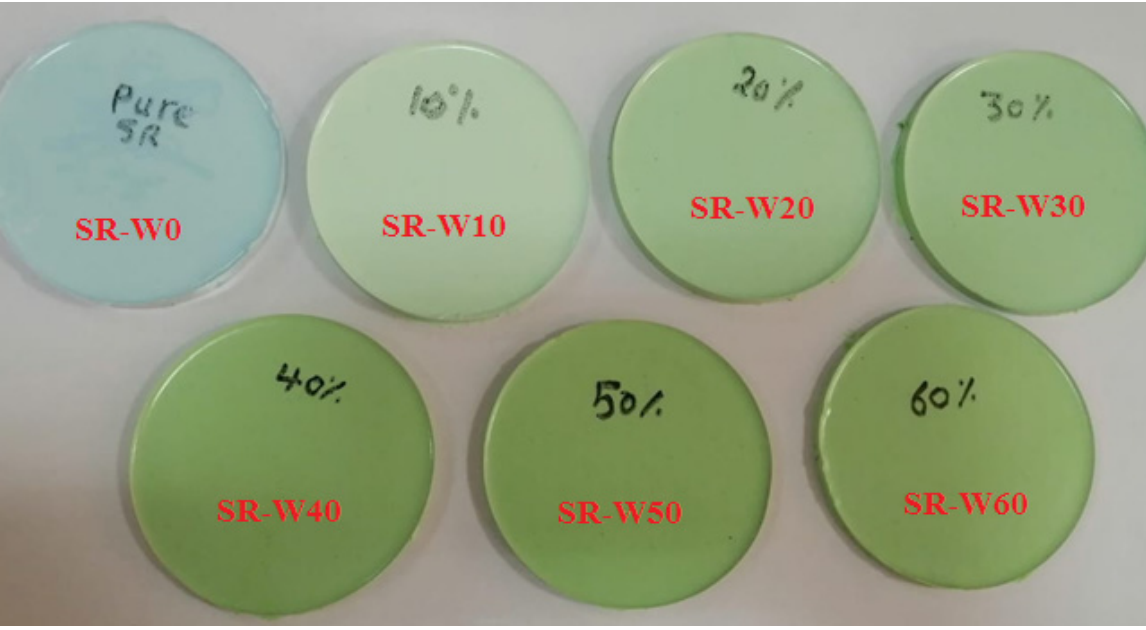
Figure 3. The prepared samples in this study.